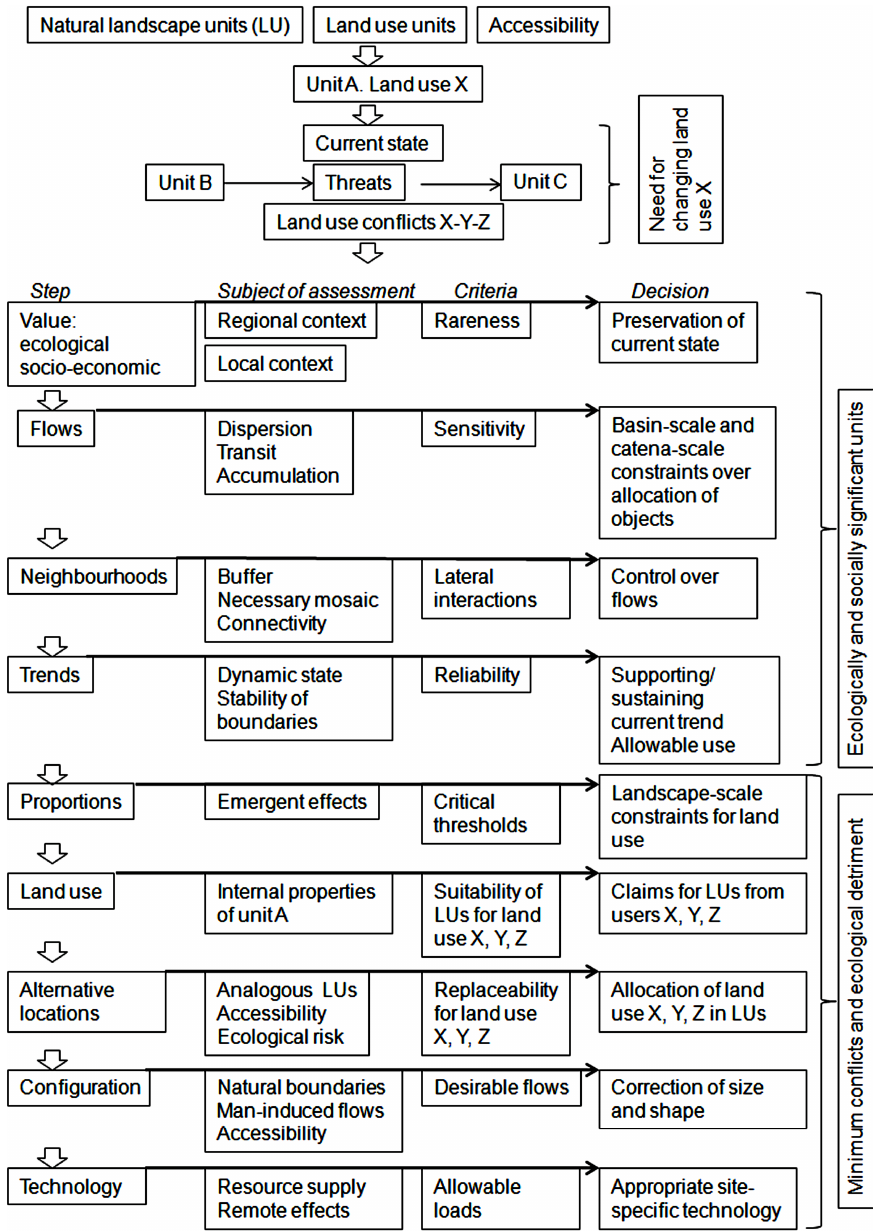
Figure 1. The framework for landscape-ecological planning. A—the focus planning unit. B and C—neighboring landscape units connected by lateral flows to A. X, Y, Z—competing land use types. 10. Which changes in land parcels configuration are needed to reduce the ecologically detrimental